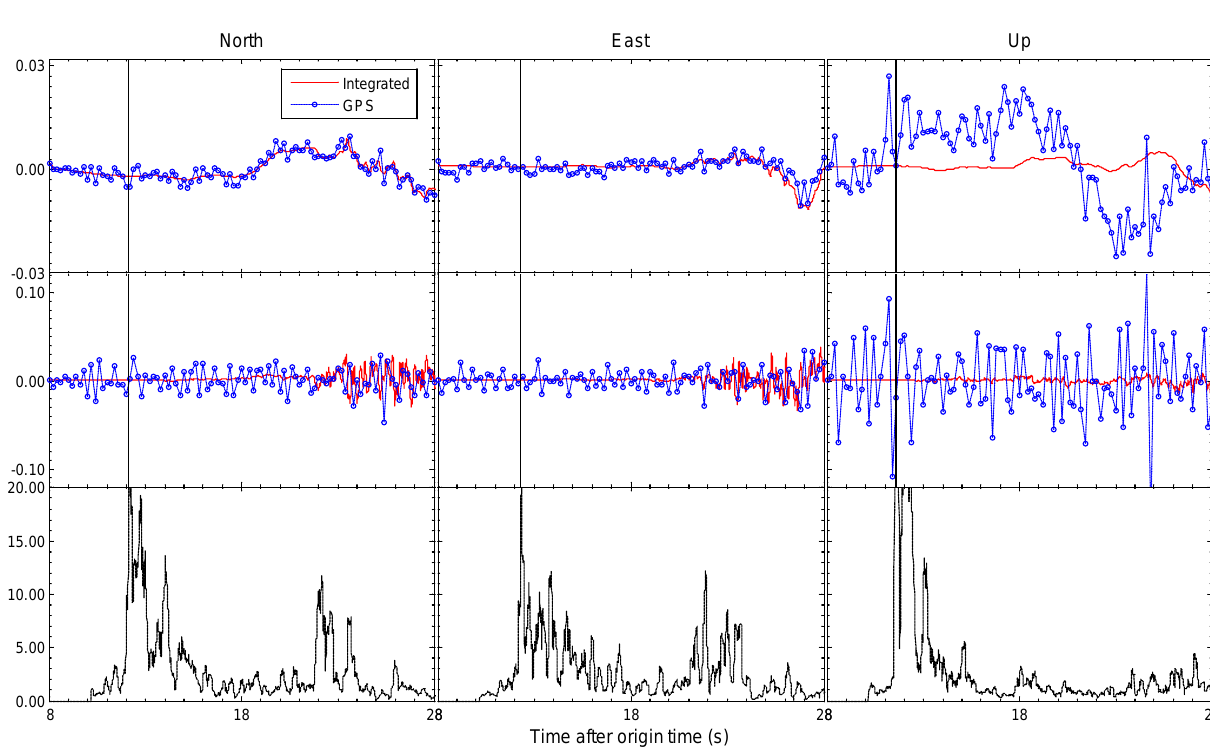
Figure 5. An enlarged view of the first 20 s of the coseismic displacements and velocities in all three components on the collocated 5028 (seismic) and P744 (GPS) pair during the El Mayor–Cucapah earthquake. The 5 Hz GPS-only and 200 Hz tightly-integrated displacements and velocities are respectively shown by the blue dotted lines and red lines. The bottom sub-figures are STA/LTA ratio results based on tightly-integrated results, which show the first arrival time of seismic wave. The sub-figures show, from left to right, the north, east and up